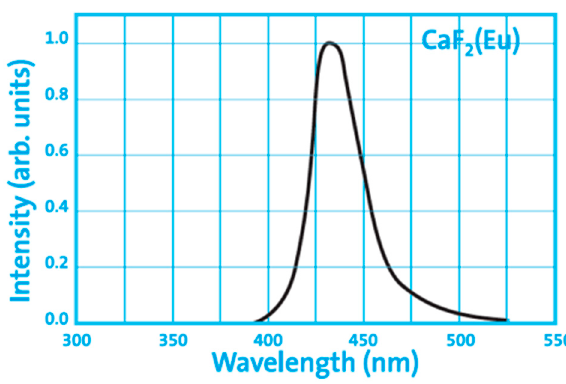
Figure 5. Emission spectrum with wavelength of CaF 2 :Eu [68].